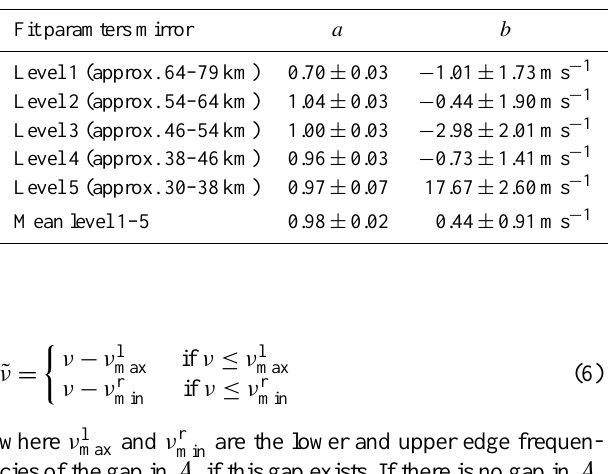
Table 3. Parameters of the fit WIRA = a ECMWF + b for the mea- surement period from 1 September 2010 to 31 July 2011. The data from WIRA are daily average zonal winds retrieved with the mirror method. The ECMWF operational analysis data were averaged to the WIRA